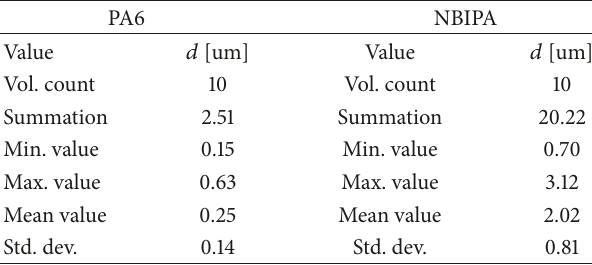
Table 1: Parameters of the electrostatic field for PA6 and